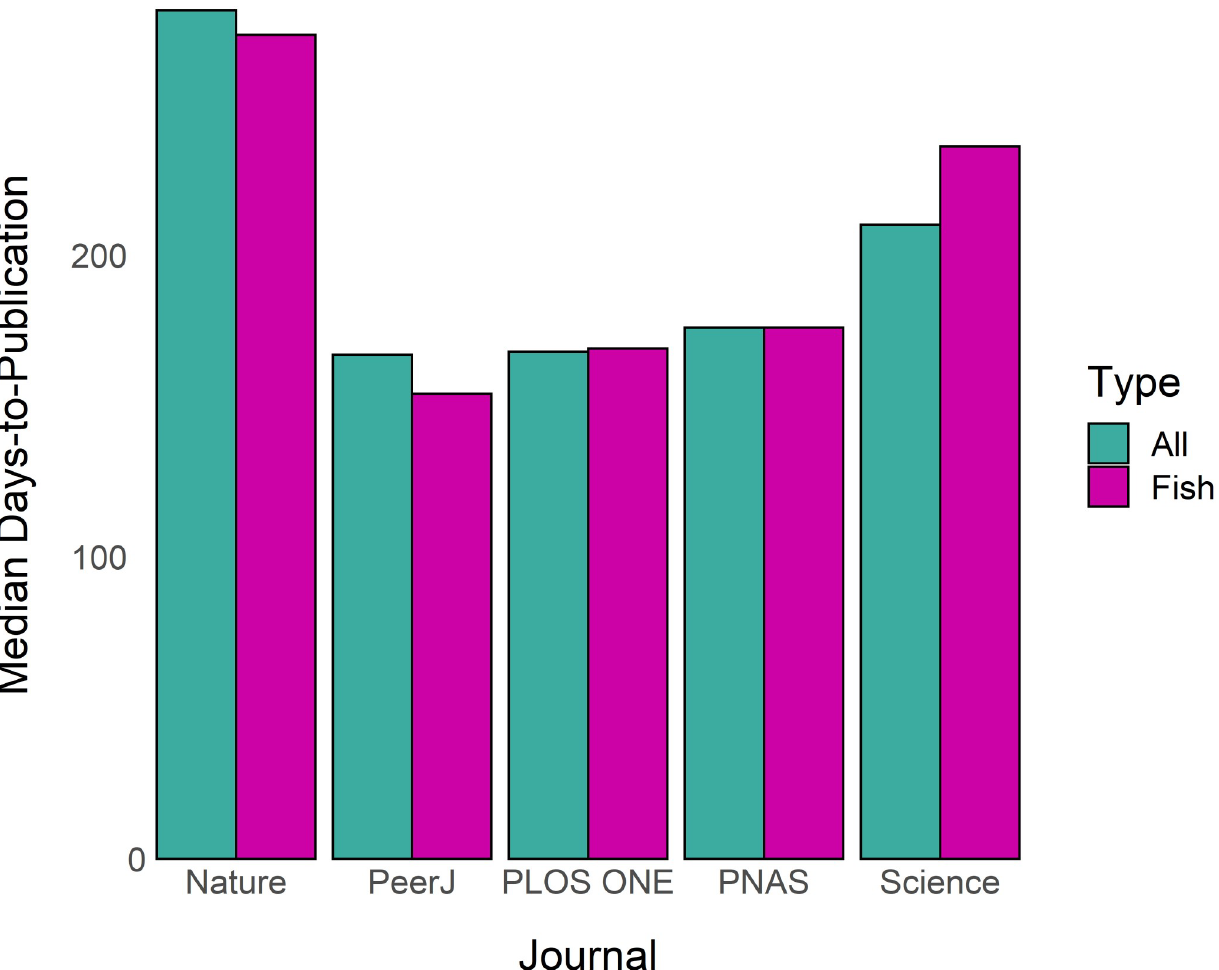
Fig 2. Median days-to-publication for all papers (green) and papers related to fish or fisheries (pink) for five broad-scope journals included in this study. PNAS is Proceedings of the National Academy of Sciences .